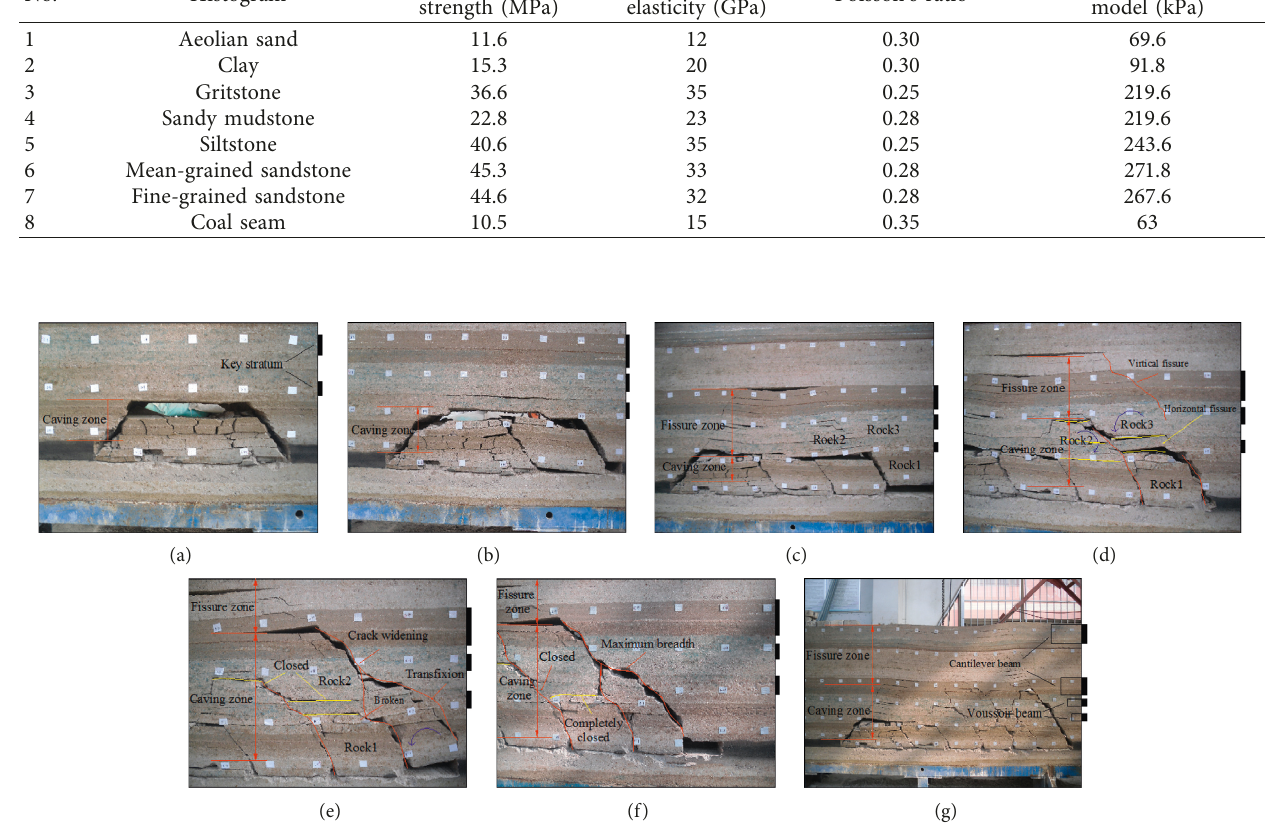
Figure 3: The evolution process of “two zone.” (a) 60m. (b) 90 m. (c) 135 m. (d) 135m, after 10minutes. (e) 50 m. (f) 165m. (g)